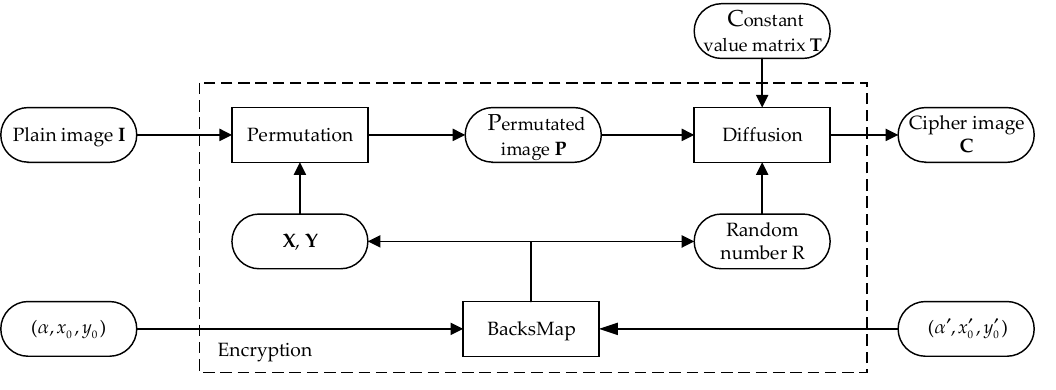
Figure 1. A general illustration of the original scheme.